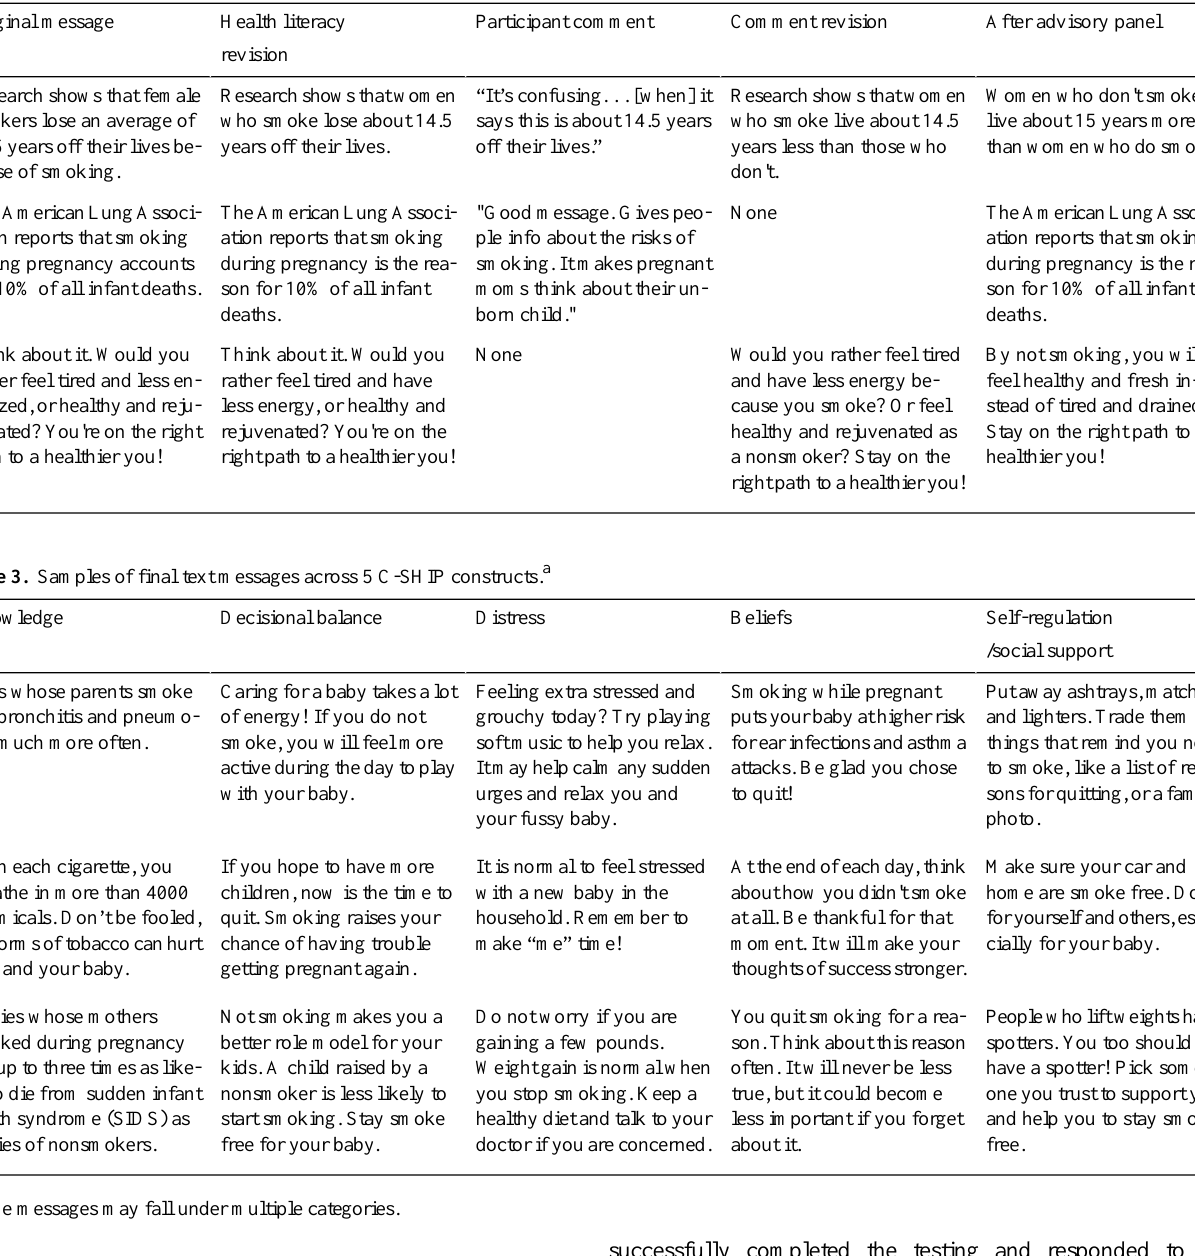
Table 2. Examples of message revision process.